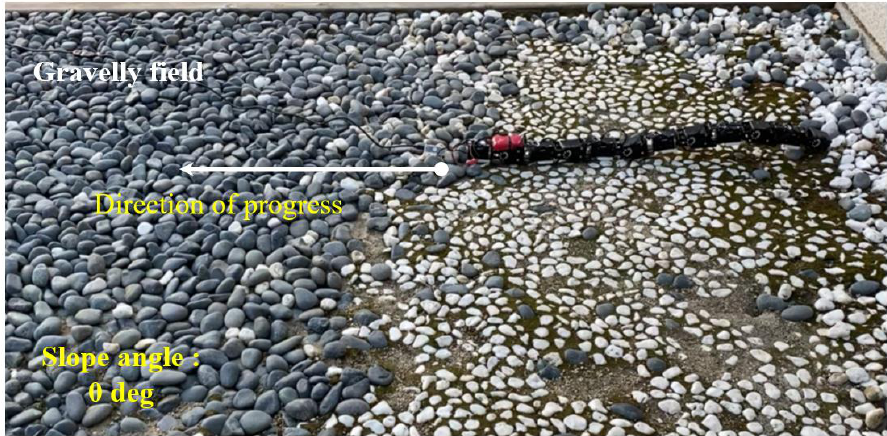
Figure 14. Gravelly field for testing the robustness of the performance of the DAM.